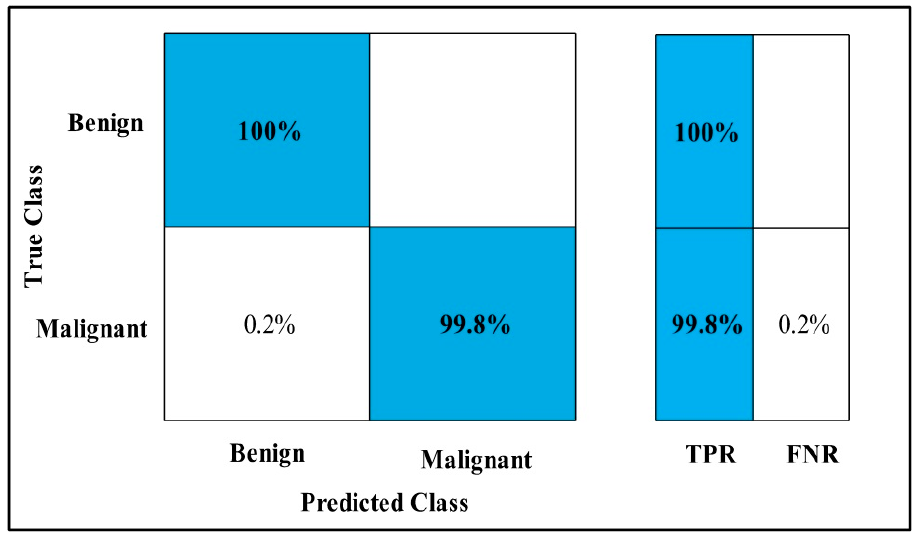
Figure 25. Fusion TPR on INbreast.